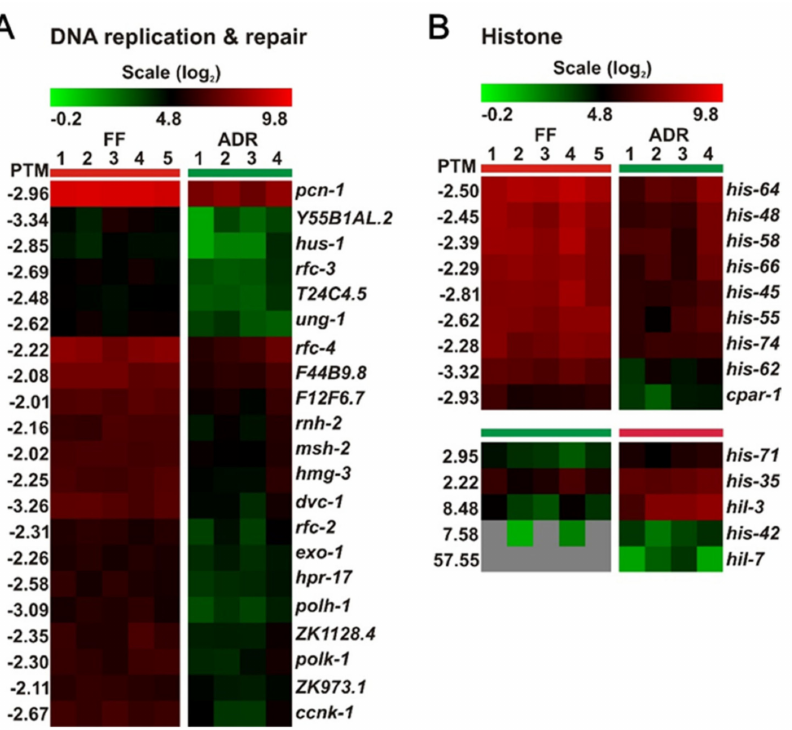
Figure 9. Differential expression of DNA replication and repair genes ( A ) and histones ( B ) in worms under fully fed (FF) and axenic dietary restricted (ADR)